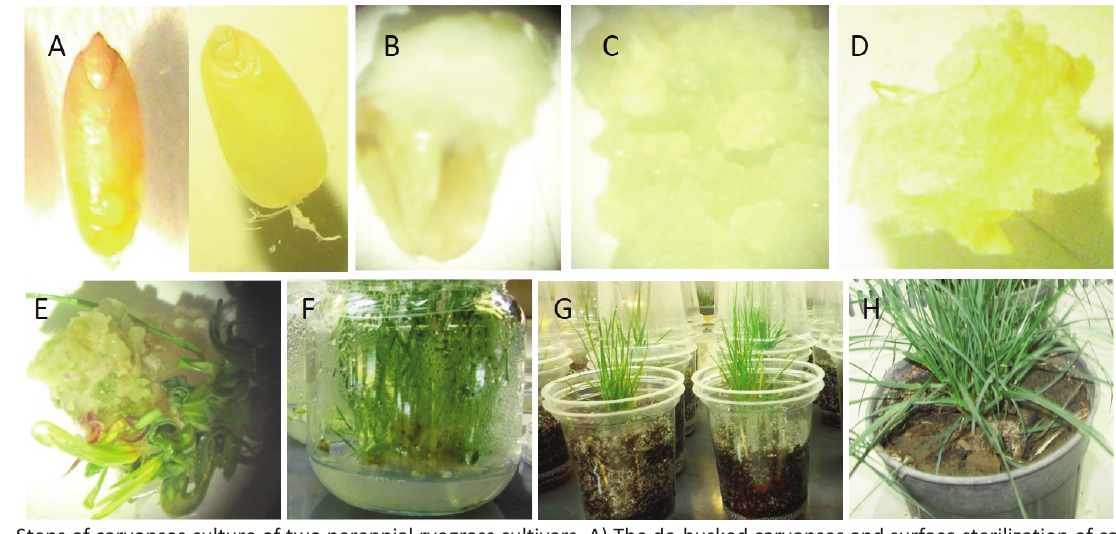
Fig. 1 - Steps of caryopses culture of two perennial ryegrass cultivars. A) The de-husked caryopses and surface sterilization of caryopses, right ‘Grassland’, left ‘Numan’. B) Calli derived from longitudinally sliced caryopsis tissue, C) Embryogenic callus type ii. D) Embryogenic callus type iii. E) Green shoots produced on embryogenic callus. F) Shoot proliferation on the regeneration medium after two weeks. G) Plants acclimatized in soil mixture after one week. H) Healthy and green plants maintained in greenhouse after one